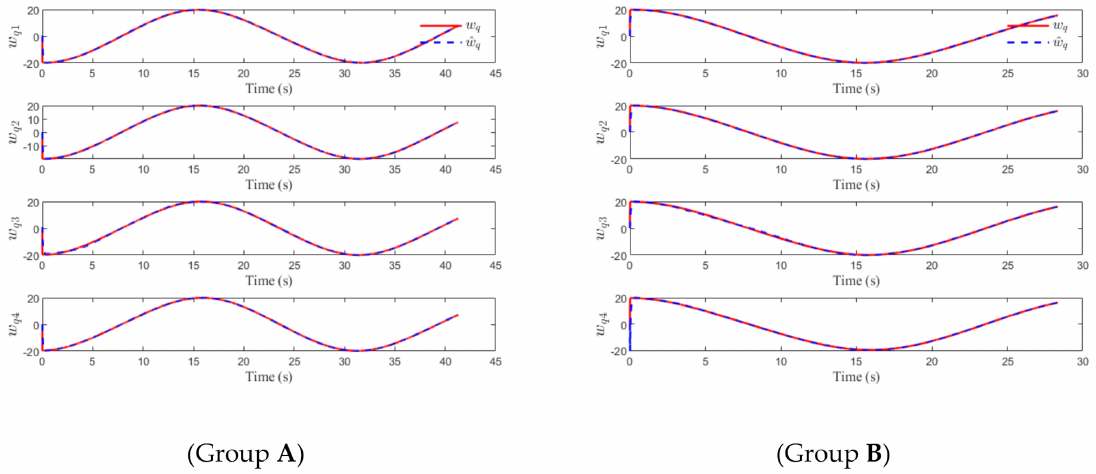
Figure 9. Actual and estimated values of external disturbance in the normal direction of LOS.